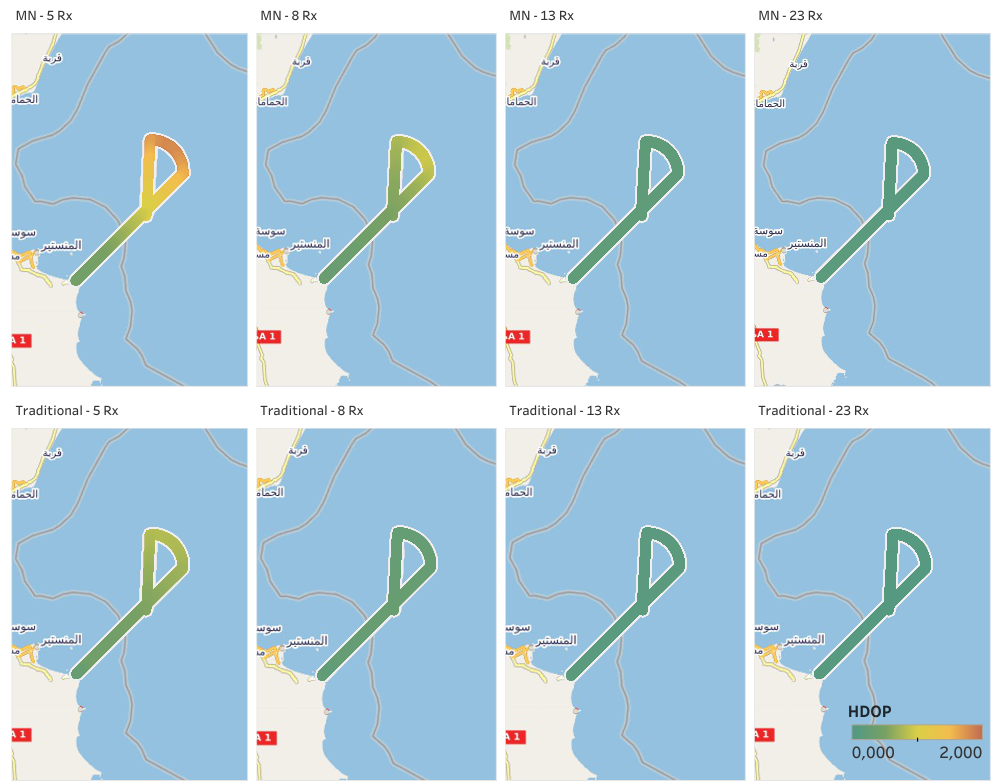
Figure 10. HDOP (colour-scale) along the vessel trajectory for the MN (top) and the traditional (bottom) TDOA in four different configurations of the receivers network (increasing number of additional receivers from left to right: BL+5Rx, BL+8Rx, BL+13Rx and